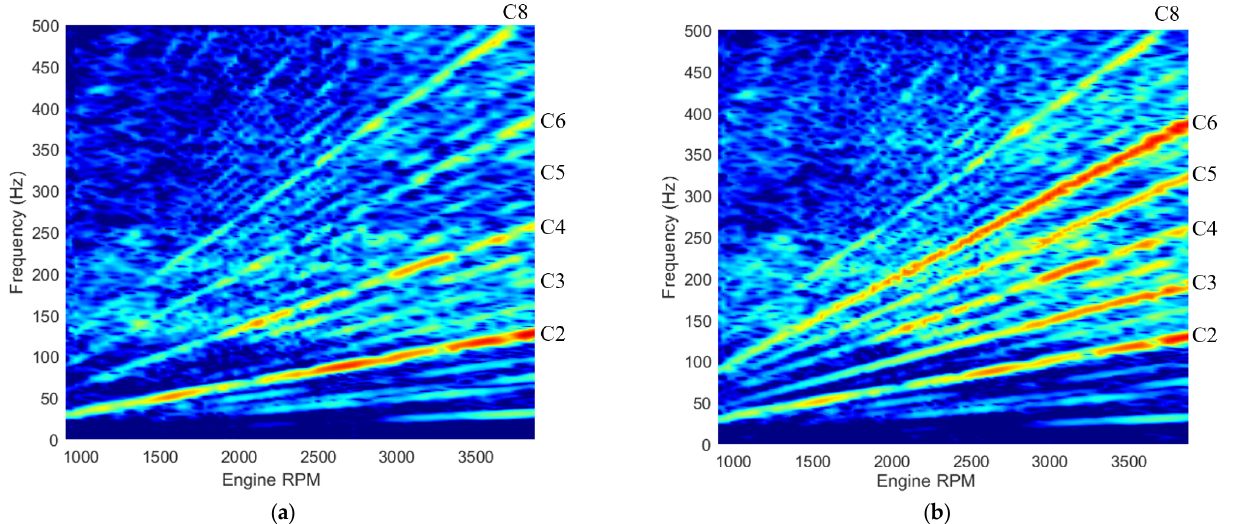
Figure 12. Engine RPM ‐ frequency spectrograms of the measured engine sounds at the driver’s ear location. ( a ) Before ASE. ( b ) After ASE.